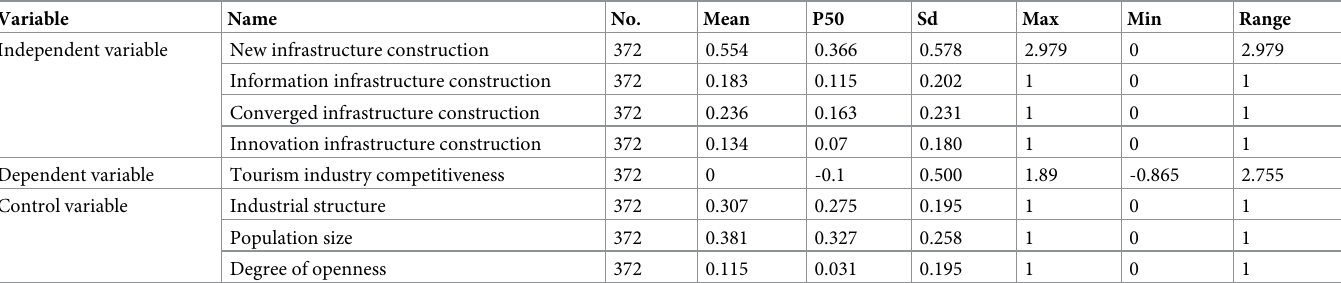
Table 3. Descriptive statistics for